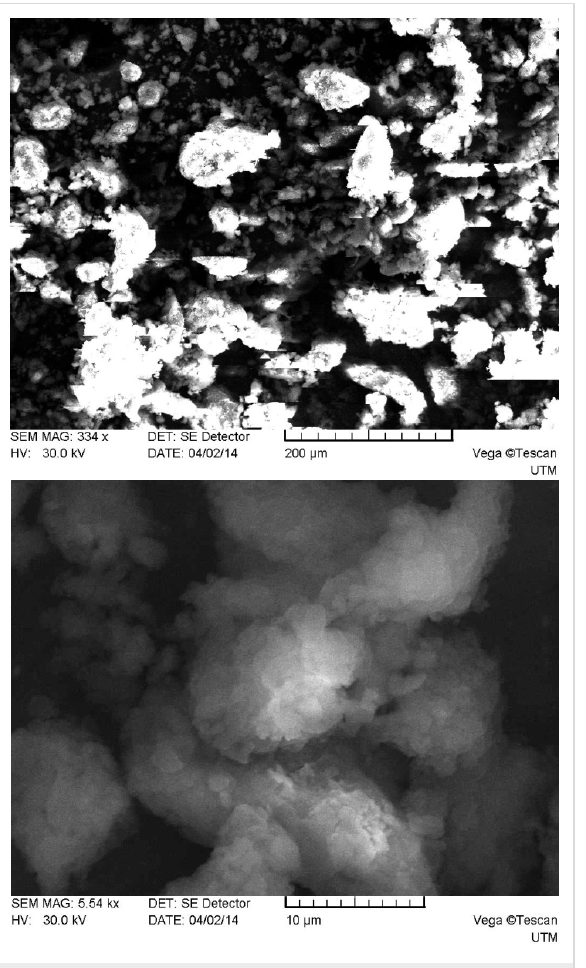
Figure 4: SEM micrographs of system 3 particles (top: magnification 338×, bottom: 6390×).